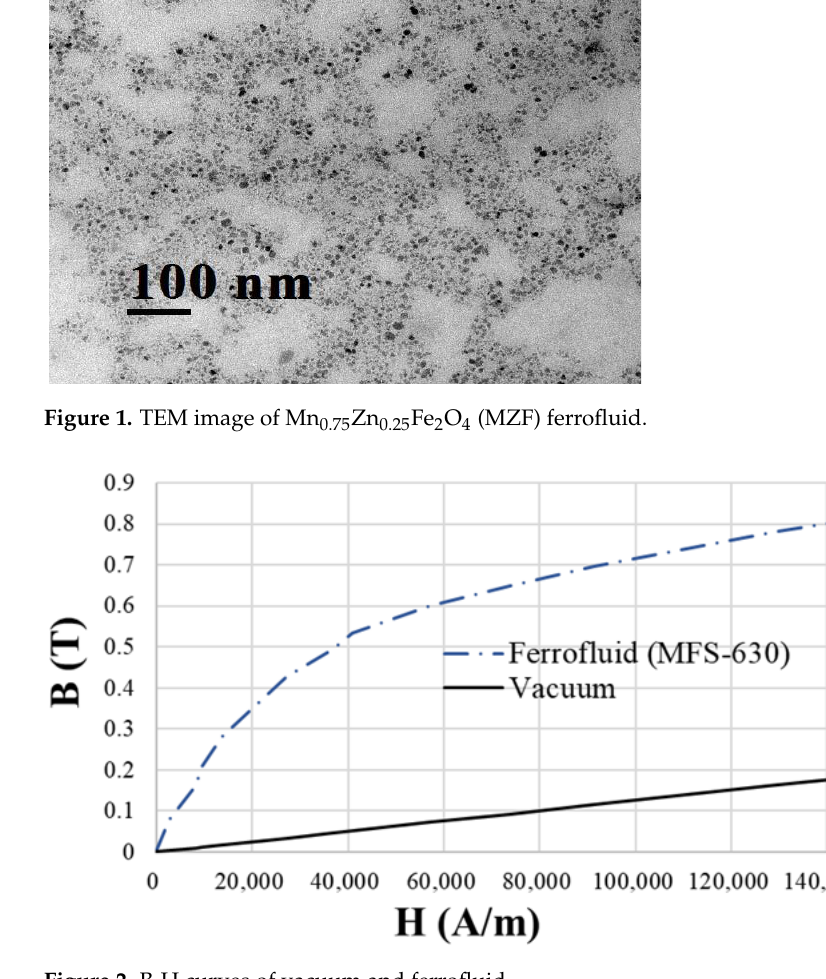
Figure 2. B-H curves of vacuum and ferrofluid.